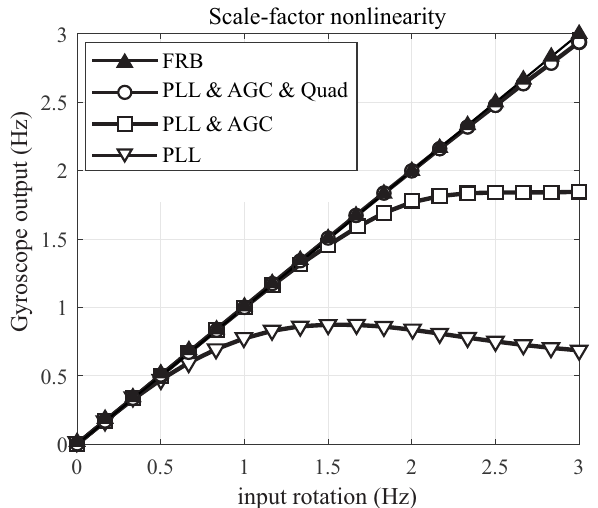
Figure 16. Experimental measurements of the scale-factor nonlinearity in DUT1, operating in the mode-matched condition with different configurations of control